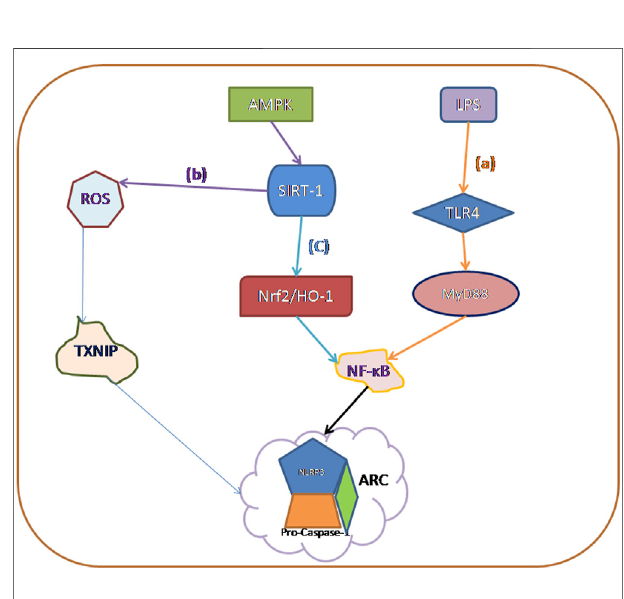
FIGURE2| Themainactivationmechanismsofvariouscaspasefamilies currently involved in pyroptosis: (A) TLR4/NF-kB In fl ammasome/NLRP3 In fl ammasome Signaling Pathway. (B) AMPK/ROS/Thioredoxin-Interacting Protein (TXNIP)/NLRP3 In fl ammasome Signaling Pathway. (C) AMPK/ SIRT1/Nrf2/HO-1/NF-kB In fl ammasome Signaling